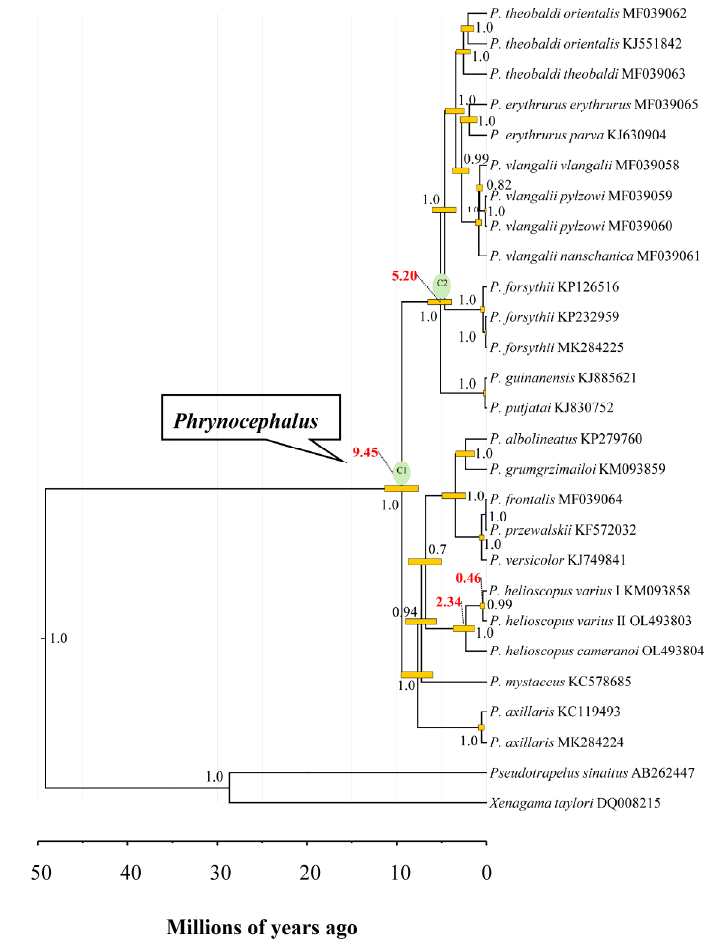
Figure 8. Timetree of Phrynocephalus spp. and two outgroup taxa estimated using BEAST based on 13 concatenated PCGs. Numbers on nodes (in black) are posterior probability values, while those in red highlight the mean divergence times in the P. helioscopus and Phrynocephalus . The yellow boxes indicate the 95% HPD of the node age in Phrynocephalus .